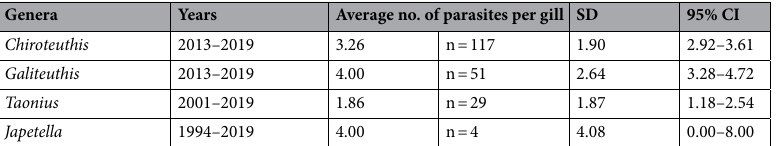
Table 2. Average infection intensity of H. cf. moroteuthensis per gill of ROV-observed specimens. n, number of gills with parasites; SD, standard deviation; 95% CI, confidence interval.